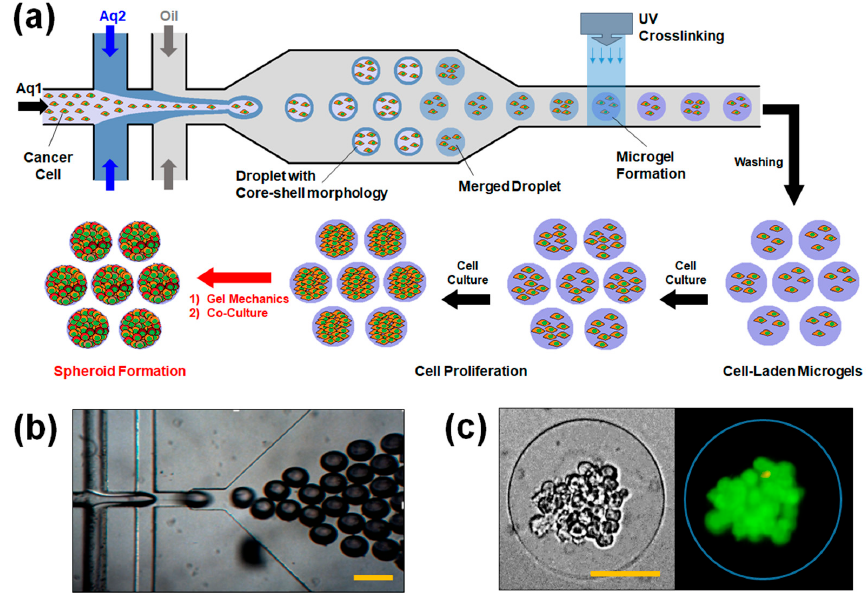
Figure 1. ( a ) Schematic illustration of the fabrication of cell-laden microgels using a “double” flow-focusing microfluidic device. Droplets of gel precursor solution dispersed with tumor cells